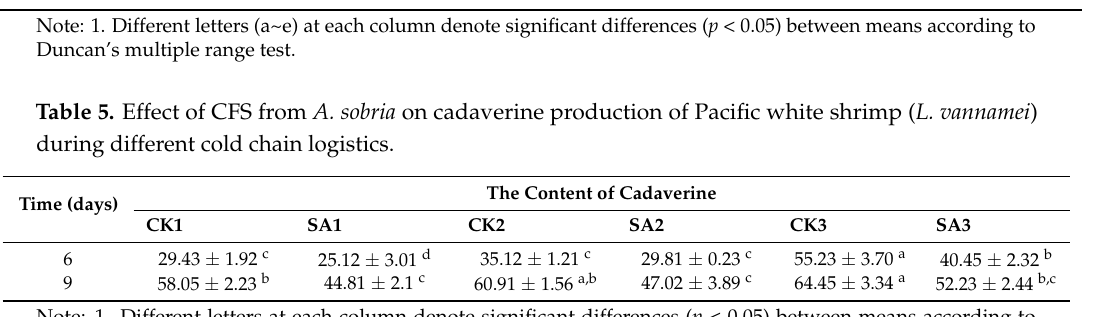
Table 6. Effect of CFS from A. sobria on amino acid content of Pacific white shrimp ( L. vannamei ).